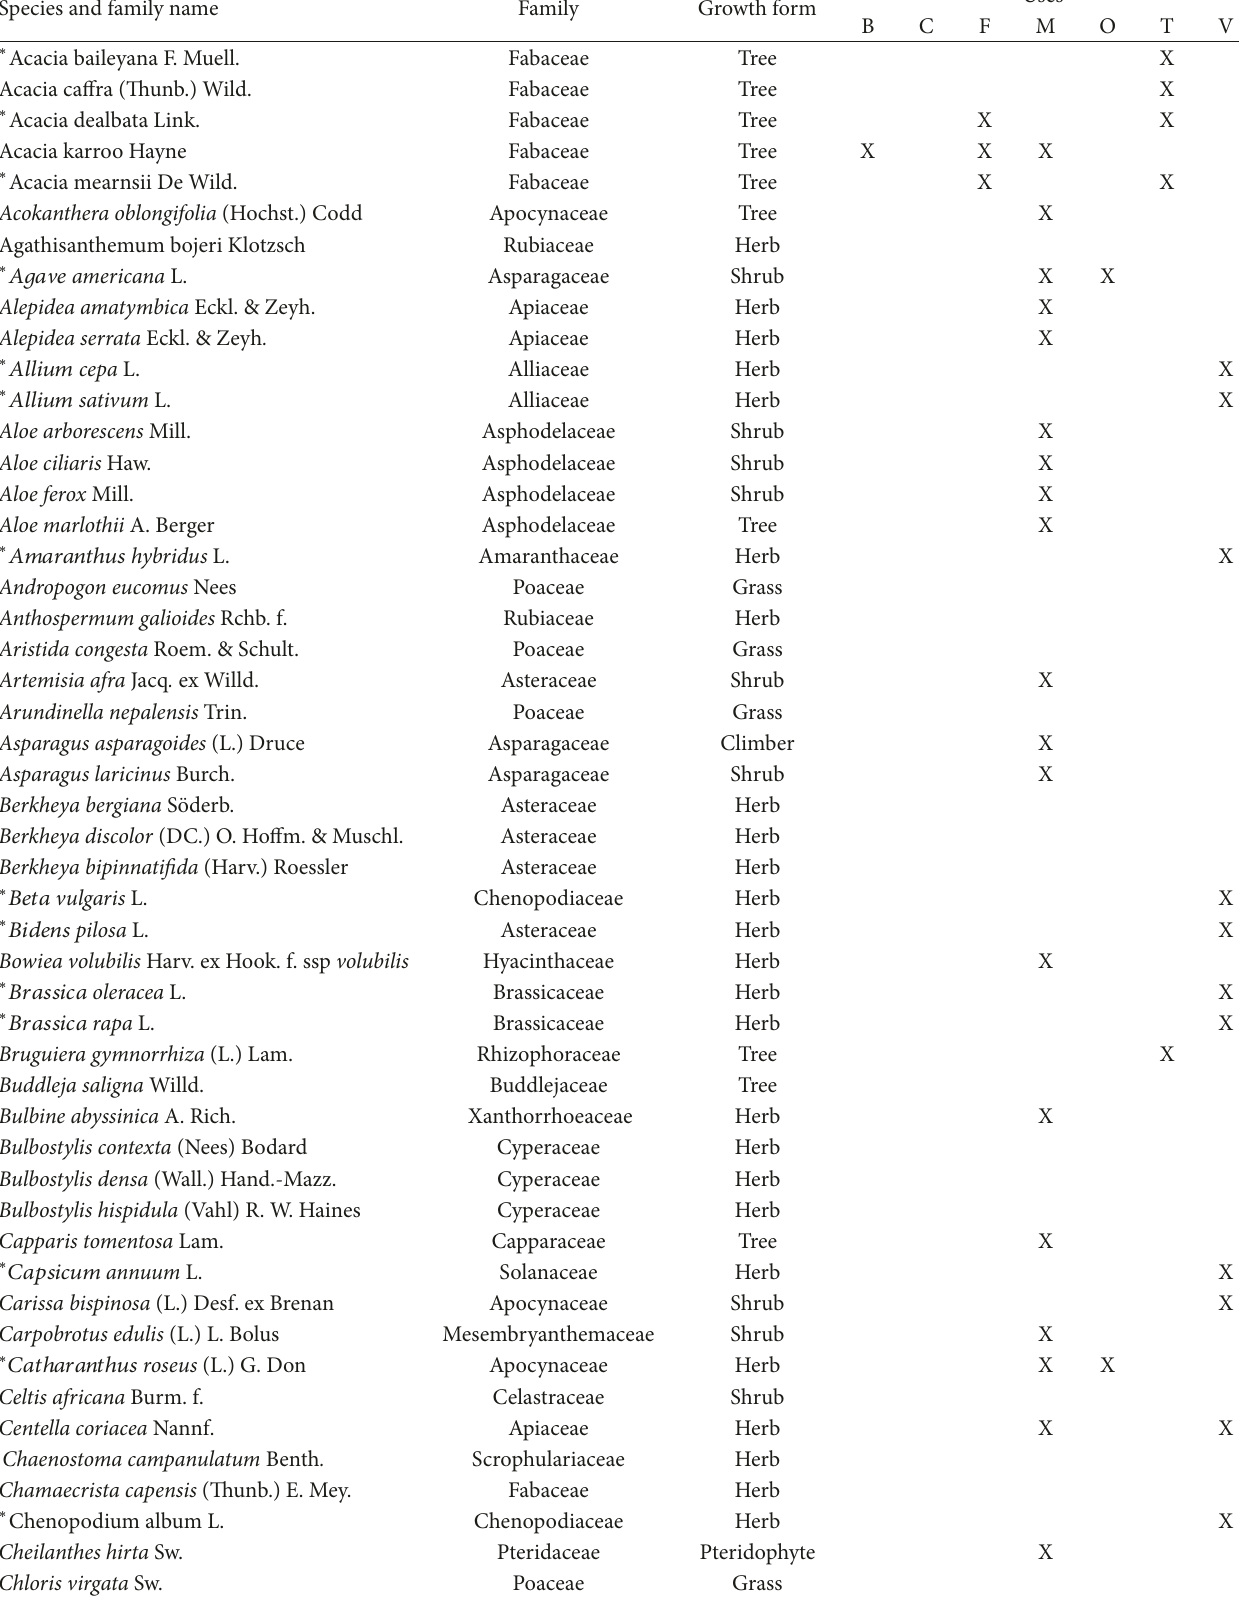
Table 1: Plant species recorded in Ntabelanga catchment area in the Eastern Cape province, South Africa. Species marked with asterisk ( ∗ ) are exotic to South